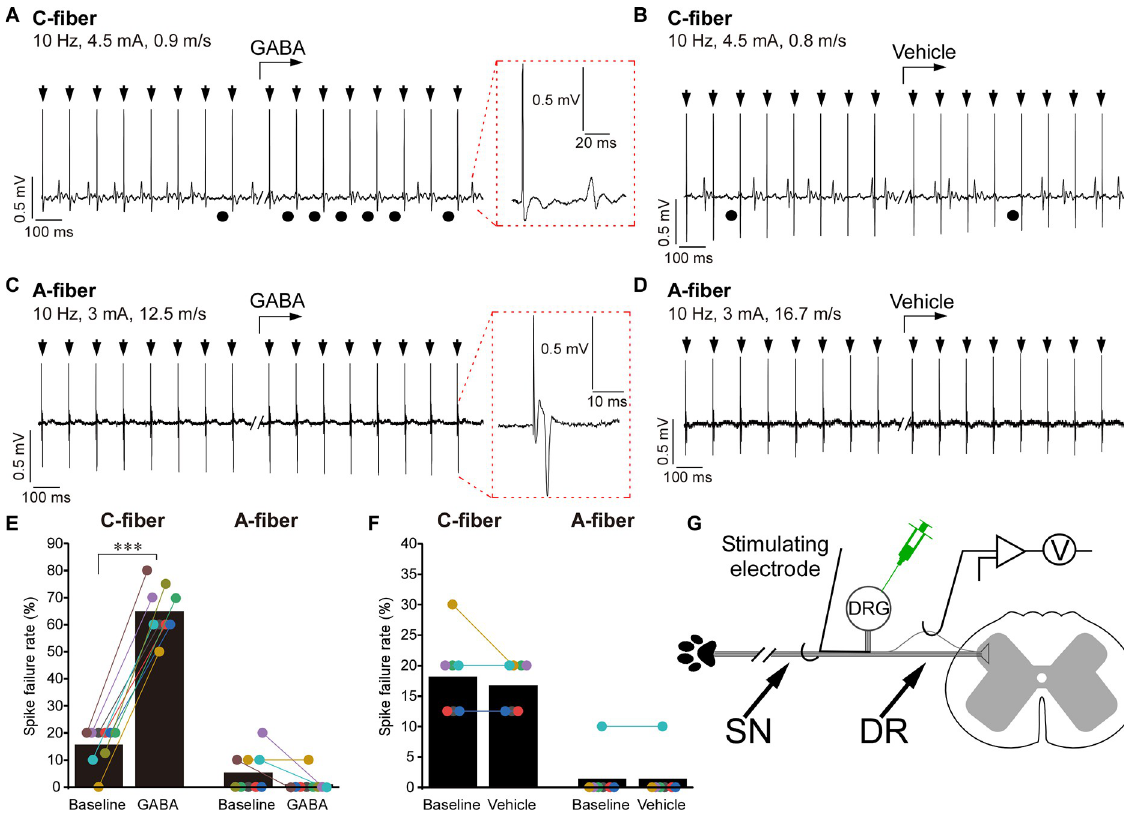
Fig 5. Single-unit recordings: DRG application of GABA induces spike failure at the DRG, which is specific to C fibers. ( A–D ) Example traces of in vivo single-unit recording from the DR process of a rat C fiber (A, B) or A fiber (C, D); stimulus electrode is placed in the SN (schematic of the experiment is shown in panel D). Parameters of stimulation and conduction velocity are indicated above the trace. GABA (200 μ M, 3 μ l; A, C) or vehicle (3 μ l saline; B, D) were applied to the DRG by a micropipettor at the time point indicated by the bent arrows. Stimulus artifacts are indicated by black arrows. Black circles under the traces indicate failed spikes. Spike waveform is shown on the extended time scale within the dotted red boxes. ( E ) Spike failure rate before and during application of GABA is analyzed for C and A fibers; n = 9 (1 recording per animal) for both fiber types; Kruskal–Wallis ANOVA: H(3) = 28.2, p < 0.001; Mann–Whitney post hoc test: ��� significant difference from control ( p < 0.001). ( F ) Similar to panel E but spike failure rates before and after the application of vehicle control are analyzed; n = 7 for both fiber types. No significant effects of the vehicle were found (Kruskal–Wallis ANOVA). ( G ) Schematic of the single-unit recording paradigm. Metadata for quantifications presented in this figure can be found at https://archive.researchdata.leeds.ac.uk/1042/. Schematics are drawn with Canvas X 2019. DR, dorsal root; DRG, dorsal root ganglion; SN, spinal nerve.